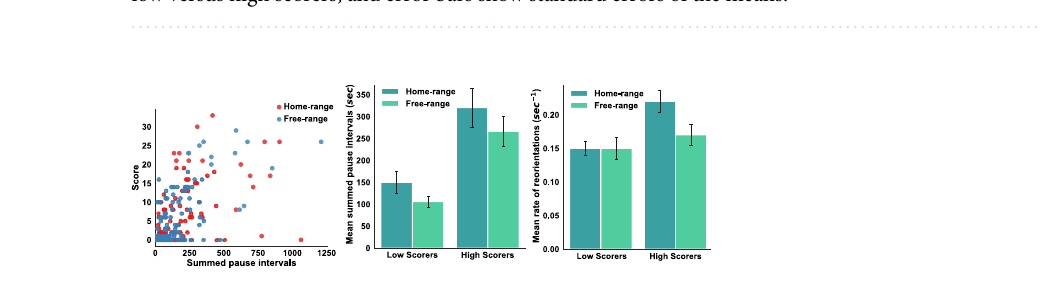
Figure 6. Mean truncated power-law exponents µ for movement segments and pause intervals (left), and mean diffusion exponents α (right) for home-range versus free-range foragers. Both measures shown separately for low versus high scorers, and error bars show standard errors of the means.